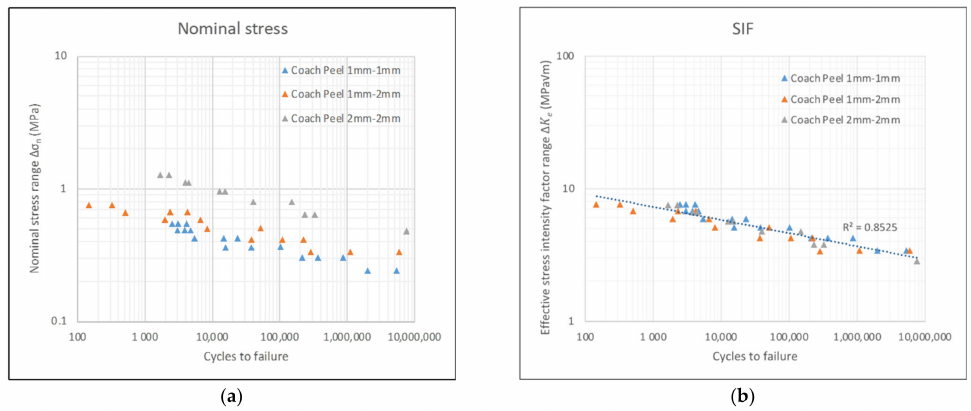
Figure 14. The test data correlation of the coach-peel test specimens. ( a ) Nominal stress range. ( b ) Effective stress intensity factor range.